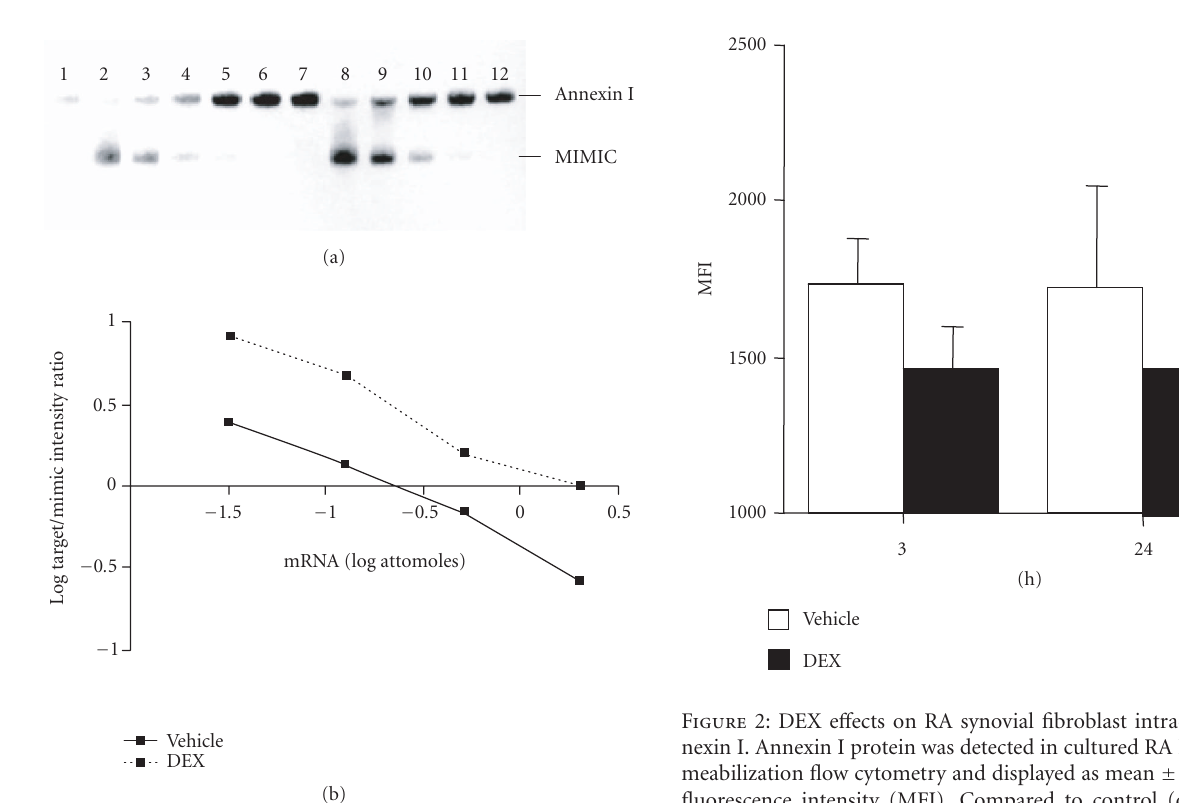
Figure 1: DEX e ff ects on RA synovial fibroblast annexin I mRNA. Panel (a): RNA extracted from human RA FLS was subjected to competitive RT-PCR with (lanes 2–6 and 8–12) or without (lanes 1 and 7) mimic. Lanes 1–6: control; lanes 7–12: DEX 10 − 7 M for 24 hours. Annexin I mRNA content was greater in DEX-treated than vehicle-treated cells. Representative of n = 4 separate experiments from 4 separate RA donors. Panel (b): the log of the ratios of the annexin I and mimic PCR product band intensities were graphed as a function of the log of the amount of mimic added to the re- action. Increased annexin I mRNA is seen in DEX-treated RA syn- ovial fibroblasts. Representative of n = 4 separate experiments from 4 separate RA donors.